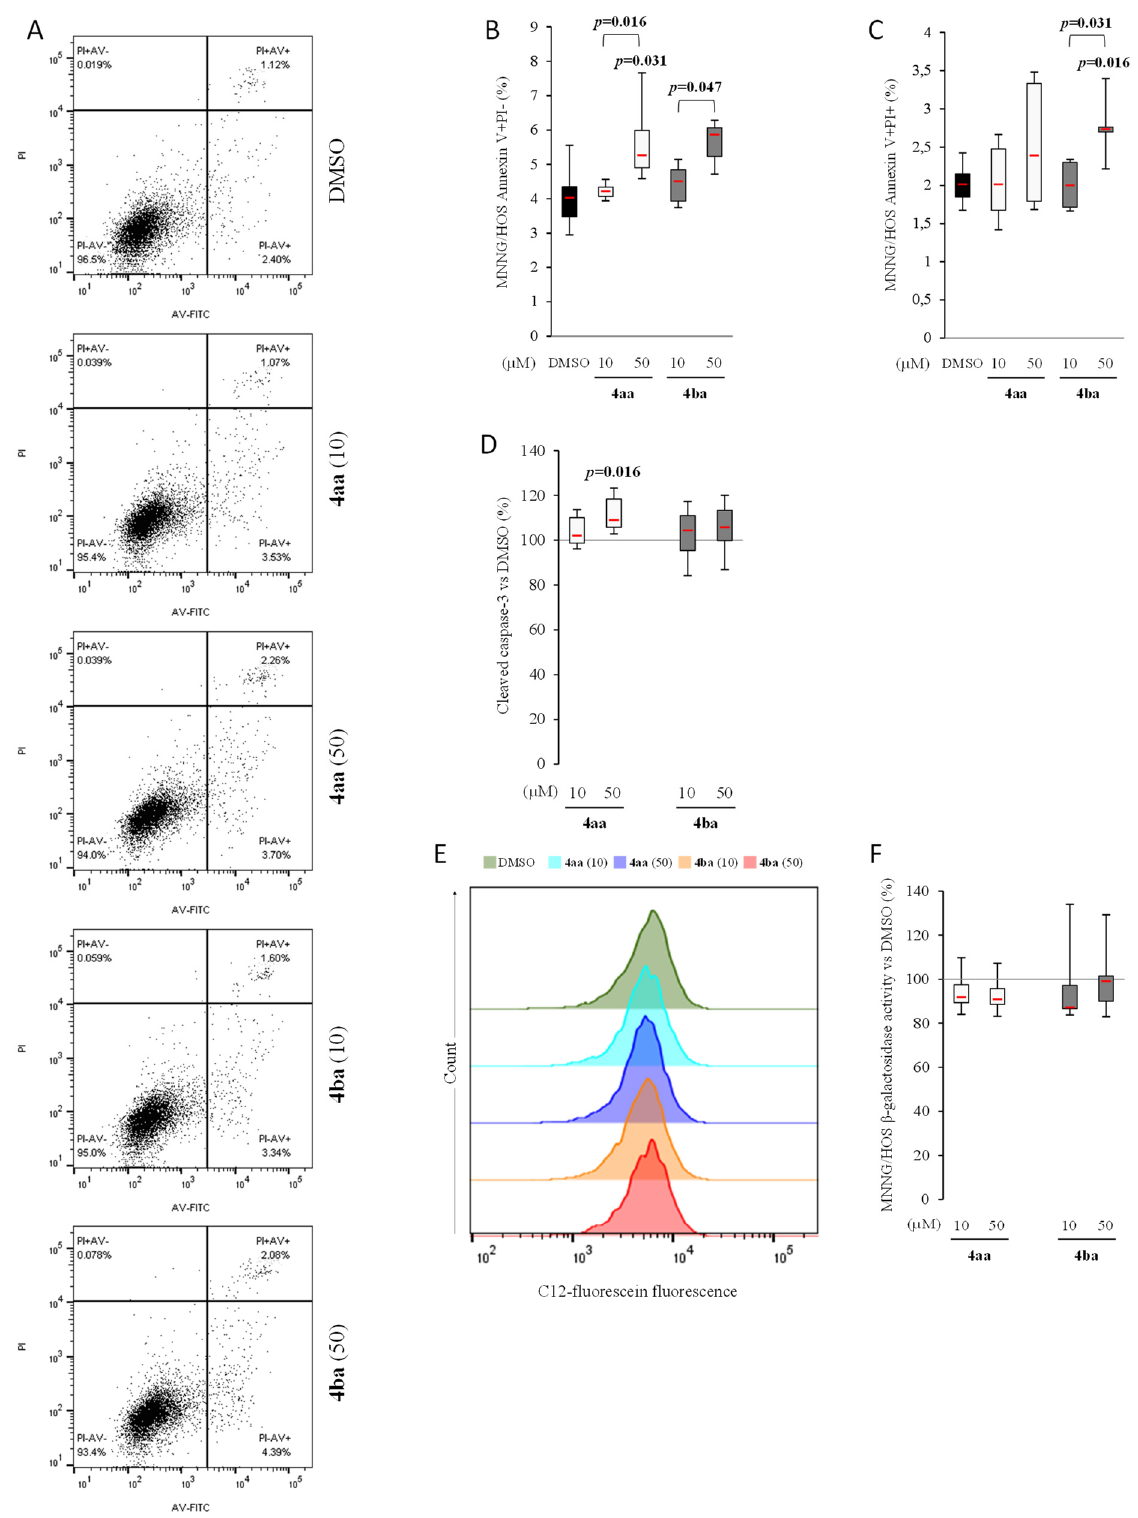
Figure 6. Pyridazinone scaffold-based molecules increase MNNG/HOS apoptosis and reduce senescence. Representative cytogram of AV and PI stain ( A ). Quantification of early (AV+/PI- cells ( B )) and late apoptosis (AV+/PI+ cells ( C )). Quantification of cleaved caspase-3 versus DMSO ( D ). Representative histograms of intracellular β -galactosidase activity ( E ) and its quantification versus DMSO ( F ). n = 7. p -values are given relative to DMSO on box-plots; the brackets indicate the conditions compared.